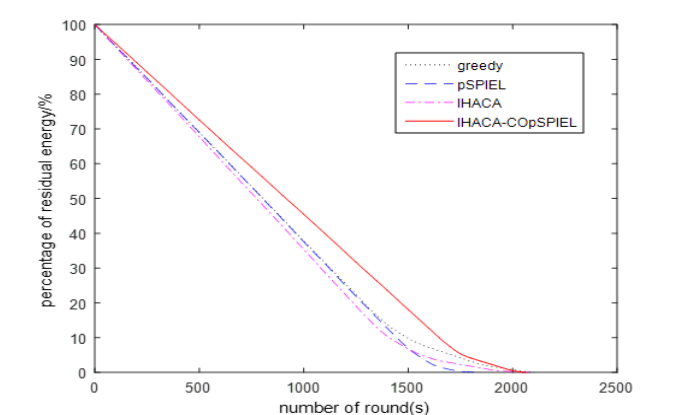
Figure 4. Percentage of remaining energy in the four